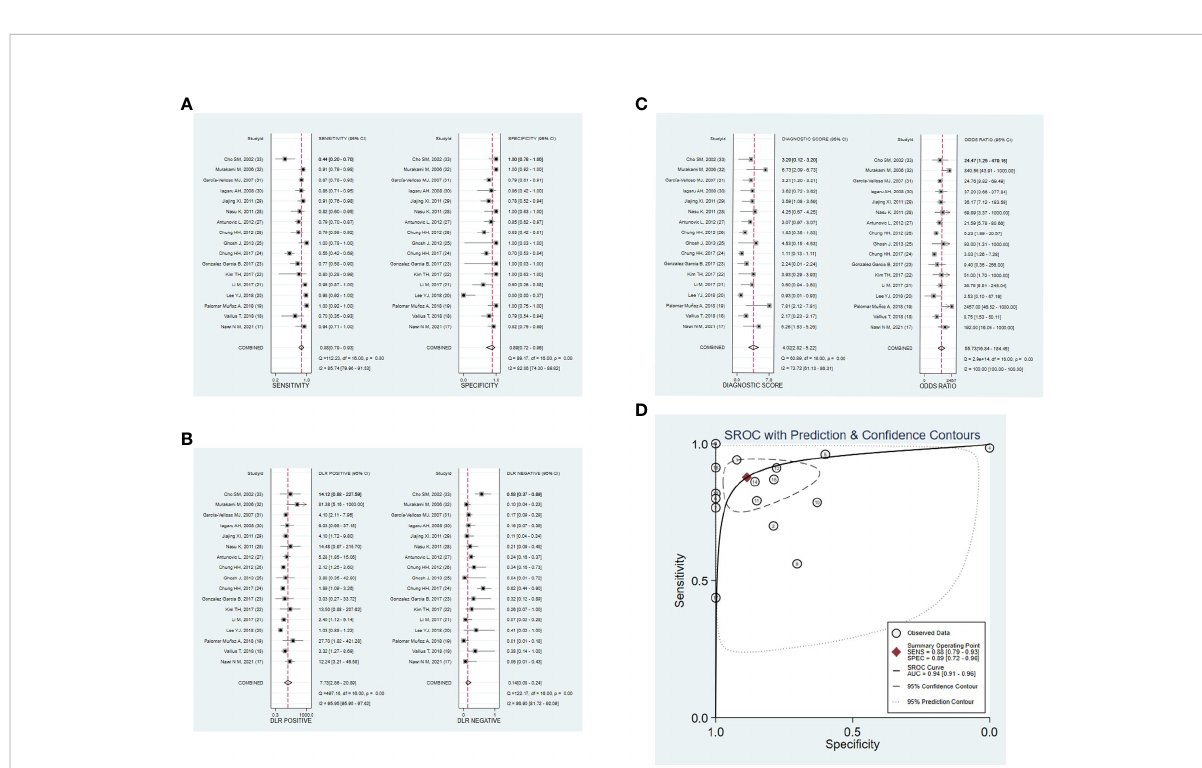
FIGURE 3 Forest plots of 18 F-FDG PET/CT for the diagnostic value of epithelial ovarian cancer. (A) sensitivity and speci fi city. (B) PLR and NLR. (C) DOR. (D) SROC. DOR, diagnostic odds ratio; PLR, positive likelihood ratio; NLR, negative likelihood ratio; SROC, summary receiver operating